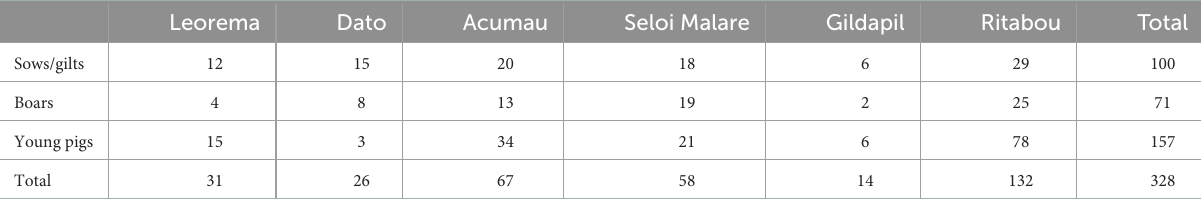
TABLE 3 Pig deaths in the last year (2019–2020).